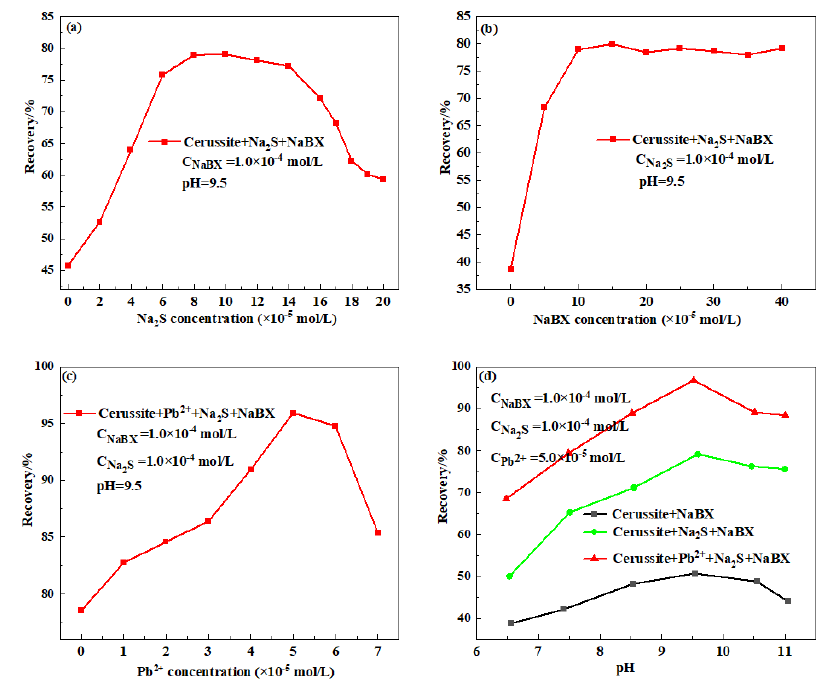
Figure 2. Flotation recovery of cerussite treated with different conditions: ( a ) Na 2 S concentration, ( b ) NaBX concentration, ( c ) Pb 2+ concentration, and ( d ) pH.